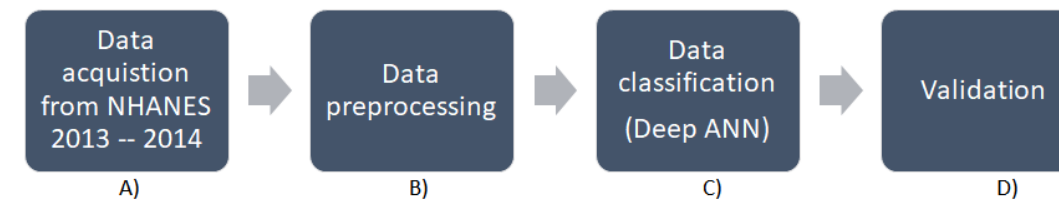
Figure 1. Flowchart of the methodology